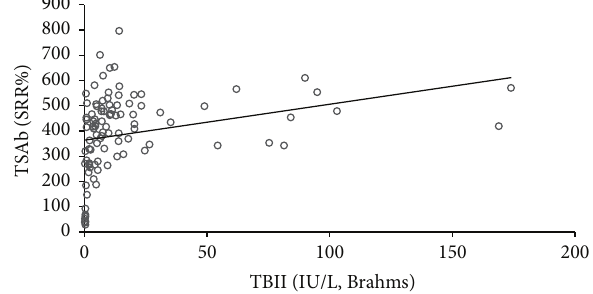
Figure 4: Correlation of serum TSAb levels with the total severity eye score. Spearman’s rho = 0.26, 𝑃 = 0.009 .